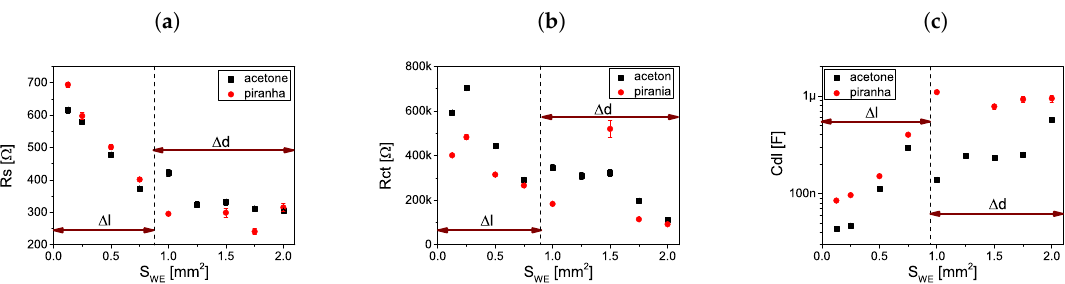
Figure 10. ( a ) Electrolyte resistance, ( b ) charge exchange resistance and ( c ) double layer capacitance as a function of the surface of the working electrode.